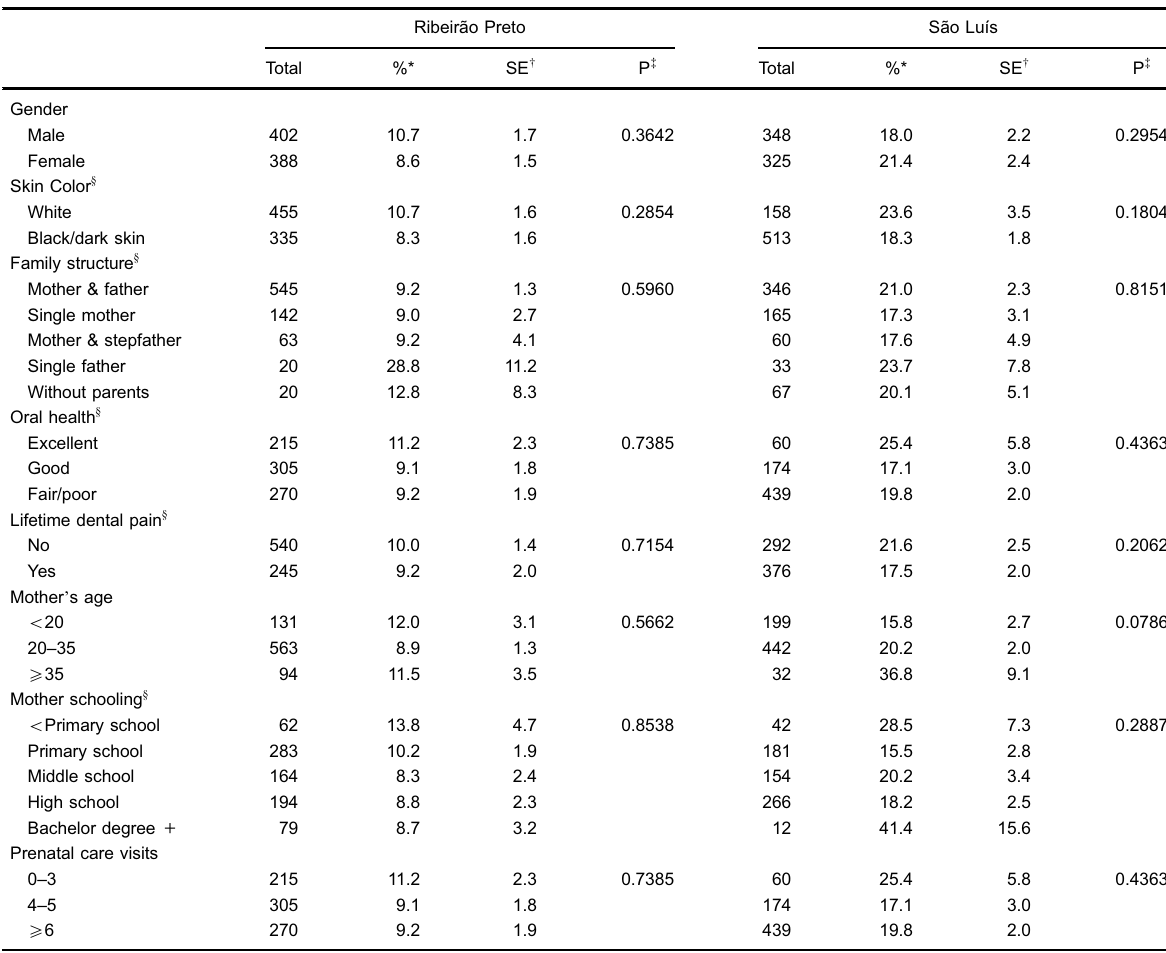
Table 1. Characteristics of those who did not answer the question about age of the fi rst dental visit in the Ribeirão Preto and São Luís cohorts (2004/2005). Ribeirão